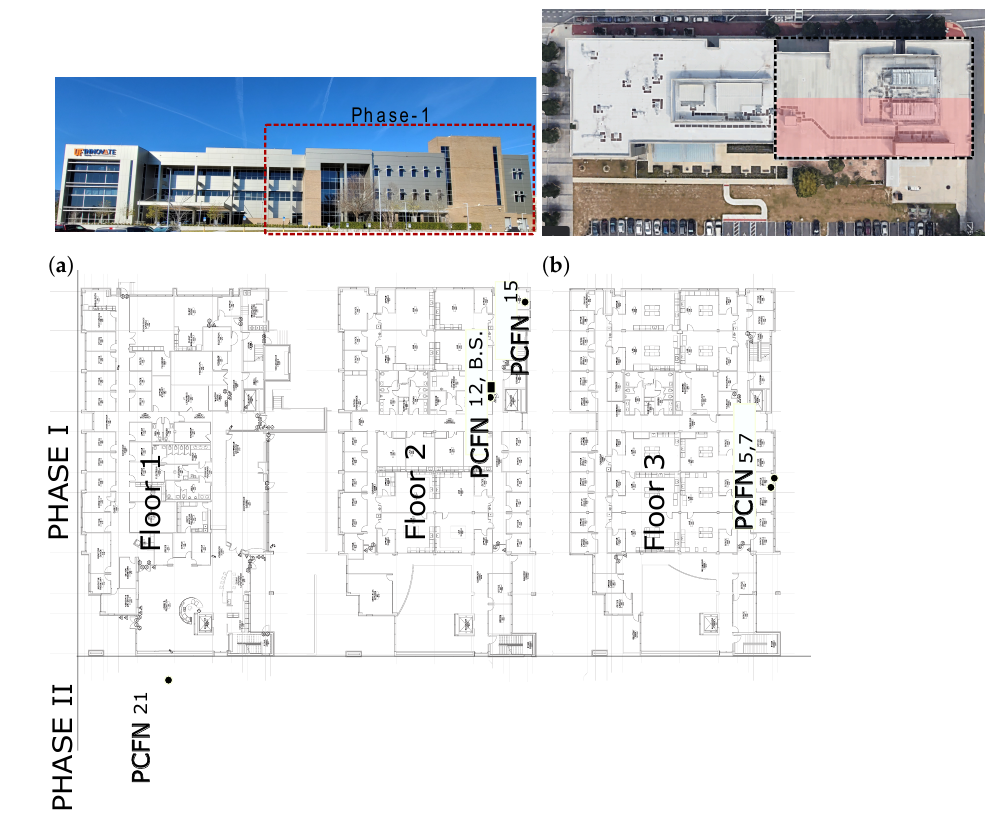
Figure 5. The deployment site, iHub (innovation hub), located at the University of Florida campus, and locations of PCFNs inside iHub. ( a ) Picture of the Innovation Hub building (view from south to north). Phase-1 is enclosed in the dashed lines; ( b ) top view of iHub. All but one of the PCFNs are deployed in the southern half of Phase-1 (shaded in blue)—served by an air handling unit (AHU-2). Imagery ©2021 Maxar technologies, U.S. geological survey, Map data ©2021 Google, maps.google.com (22 January 2021); ( c ) locations of the PCFNs deployed in iHub and that of the base station (marked as B.S.).